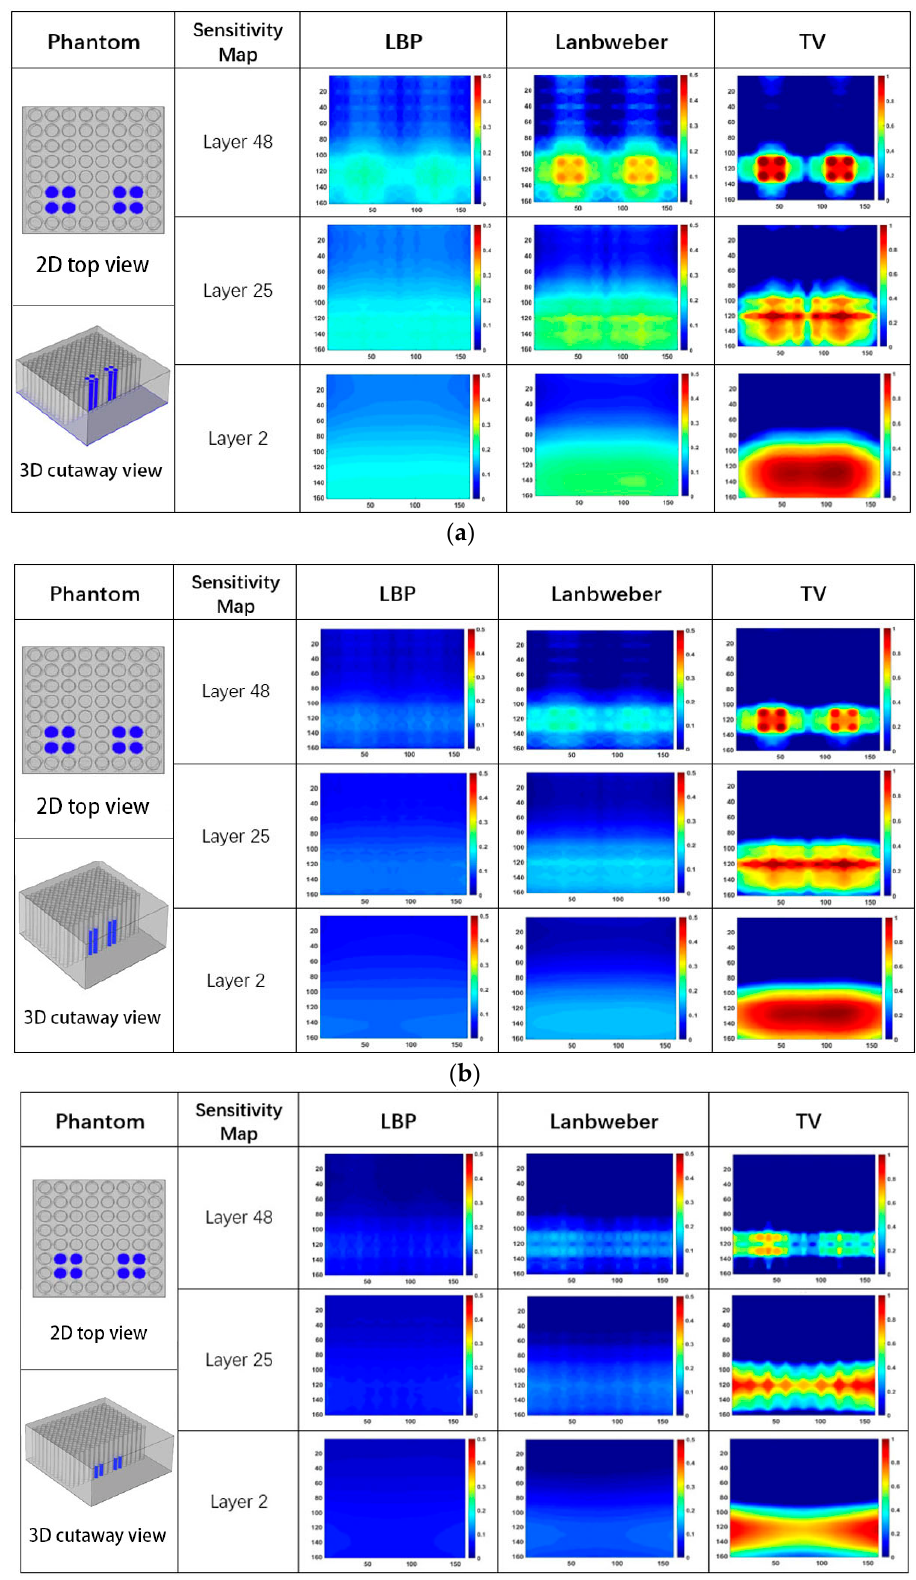
Figure 9. The imaging results while the central four column holes are full of different quantities of